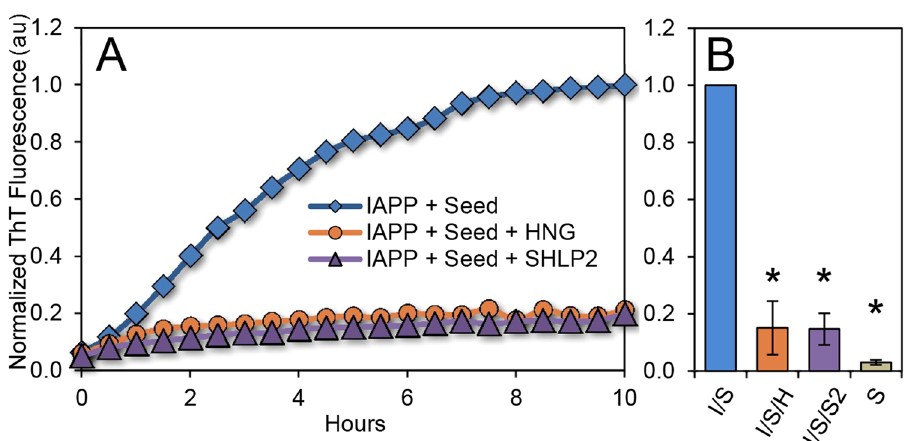
Figure 4. MDPs protect against seeding of pre-formed IAPP aggregates. ( A ) Representative fluorescence kinetics traces from 2.5 mol % seeded 12.5 μ M IAPP reactions treated with HNG or SHLP2. ( B ) Bar graph of averaged and normalized fluorescence data from (a) at 10 hours. Error bars represent + / − standard deviation from at least 3 independent measurements. * p <